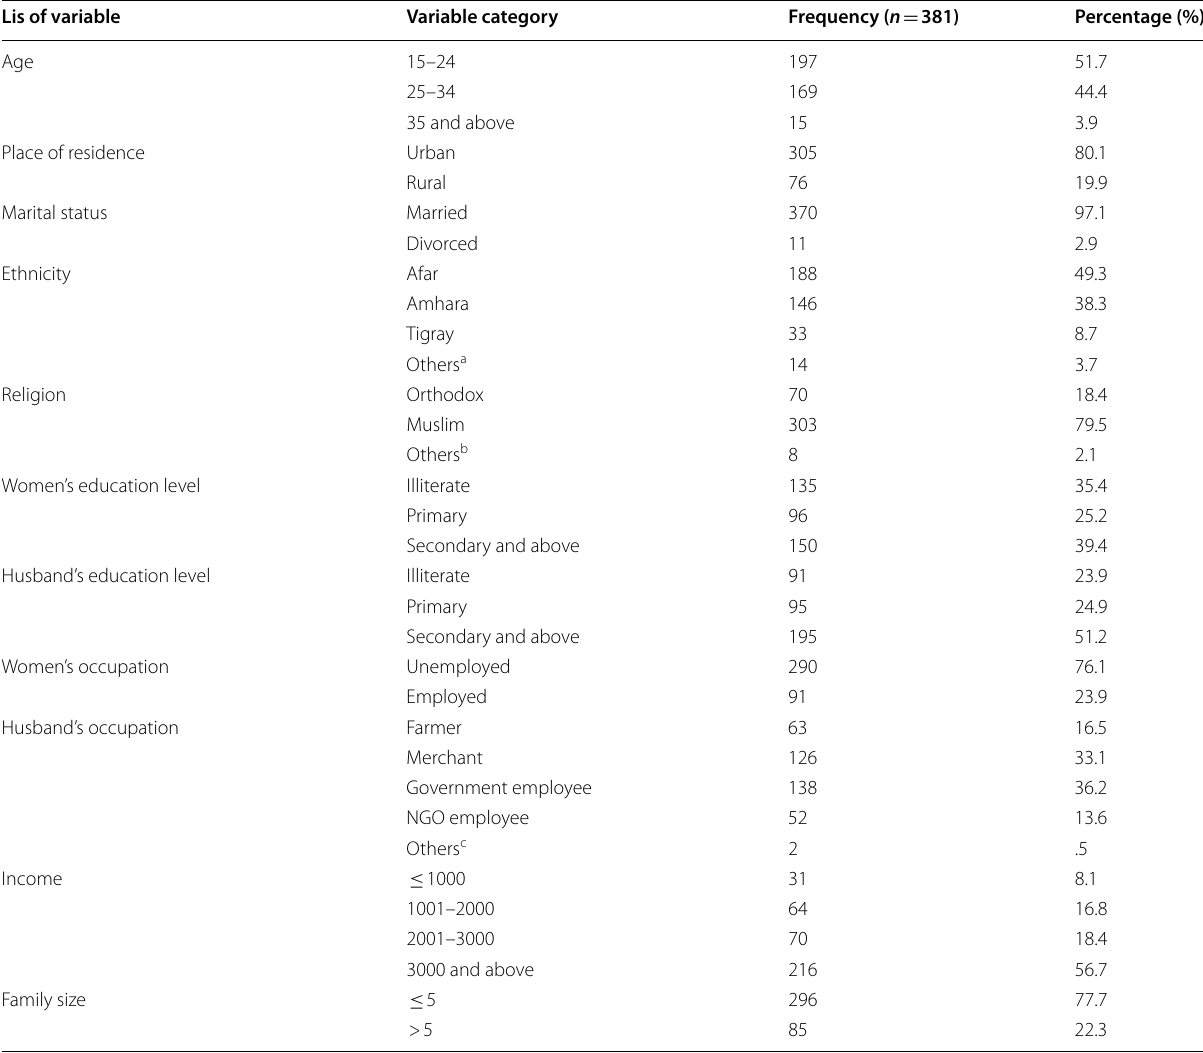
Table 1 Socio-demographic characteristics of the pregnant women in the Afar region, northeast